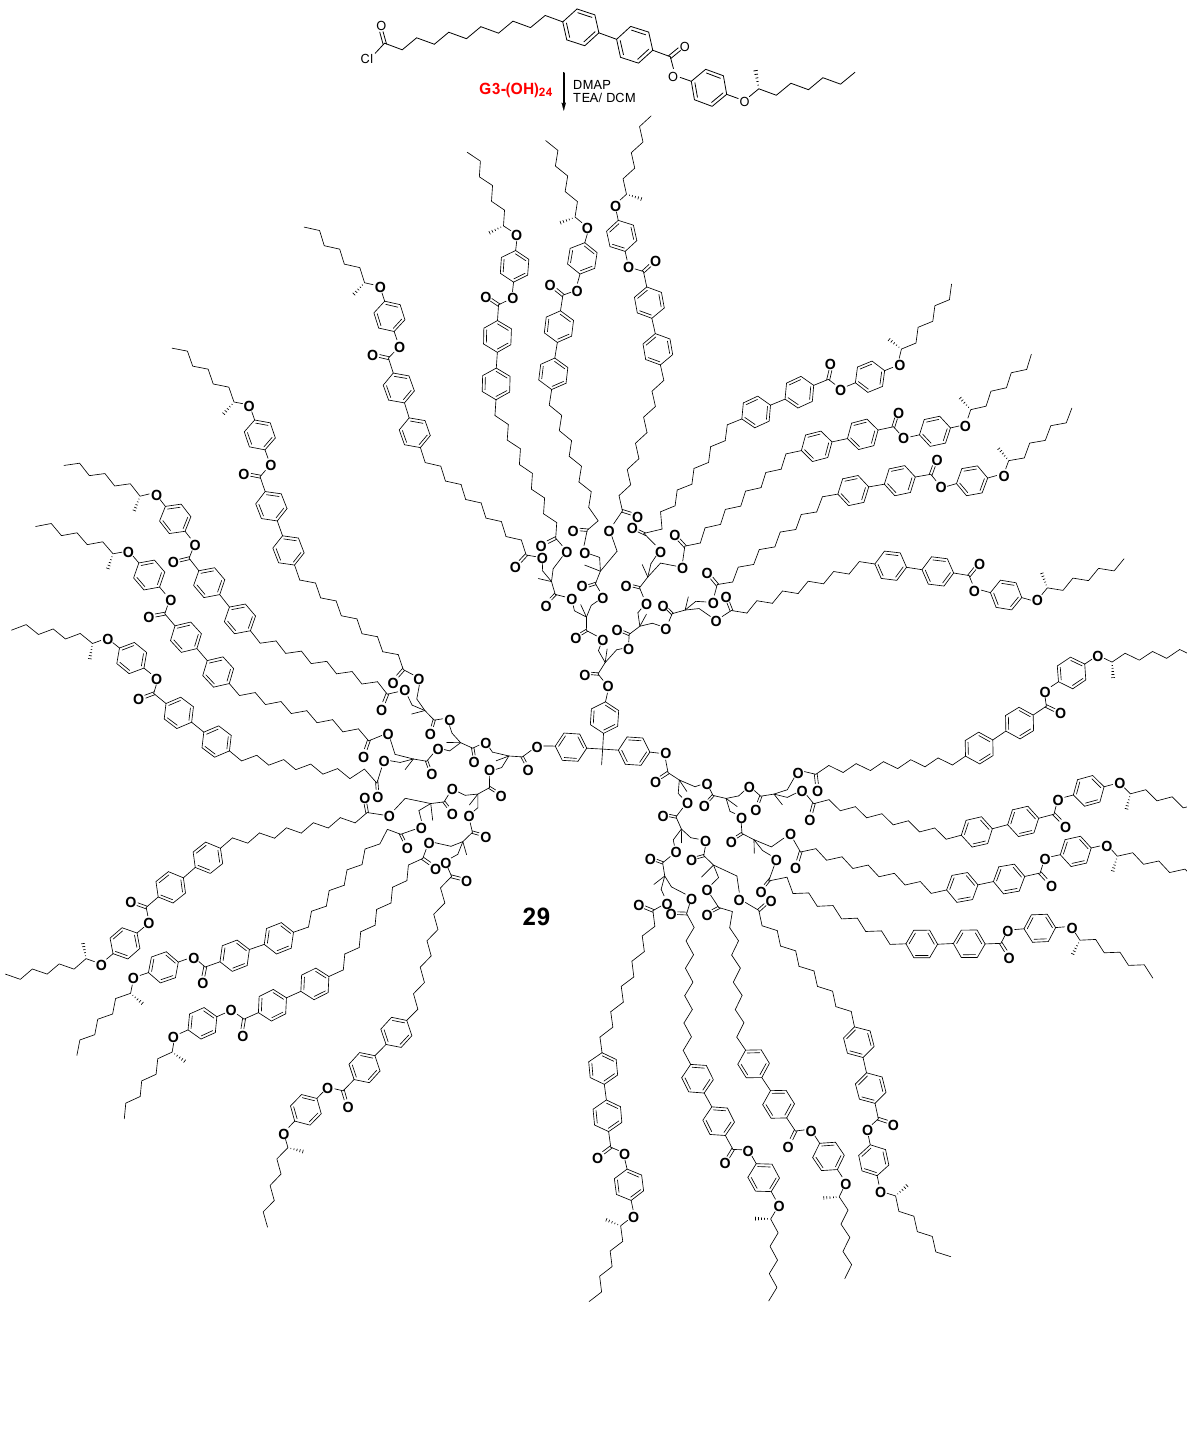
Scheme 16. Synthesis of the first ferroelectric dendritic liquid crystalline polymer